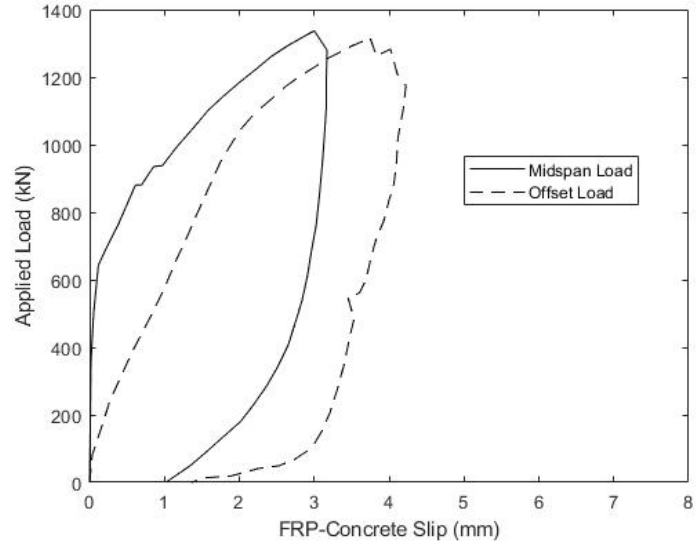
Figure 16. Beam B1 Ultimate Load-Slip Response.